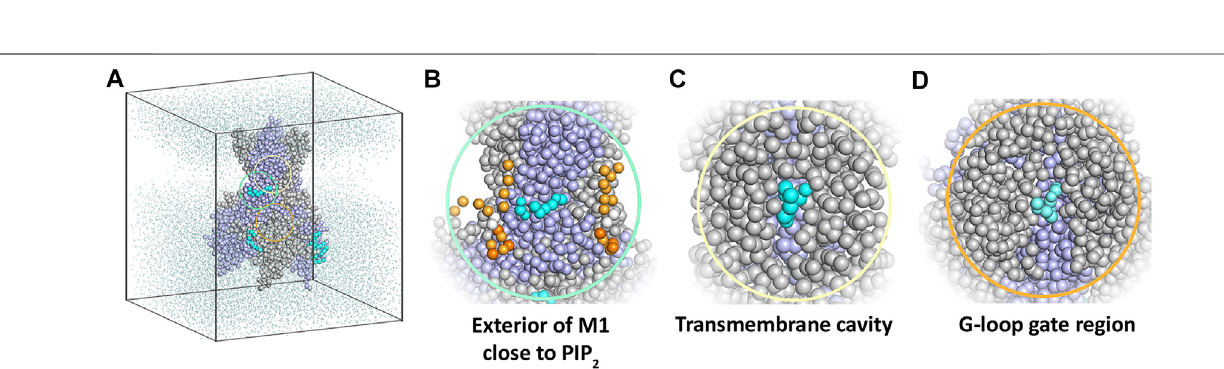
Frontiers in Pharmacology |